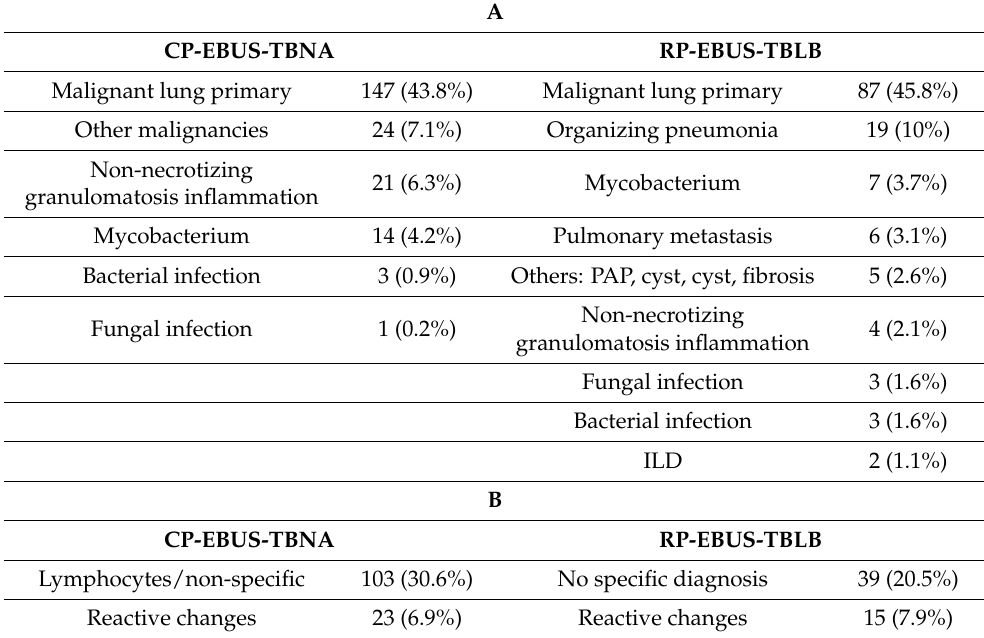
Table 3. A: specific diagnosis. B: non-specific